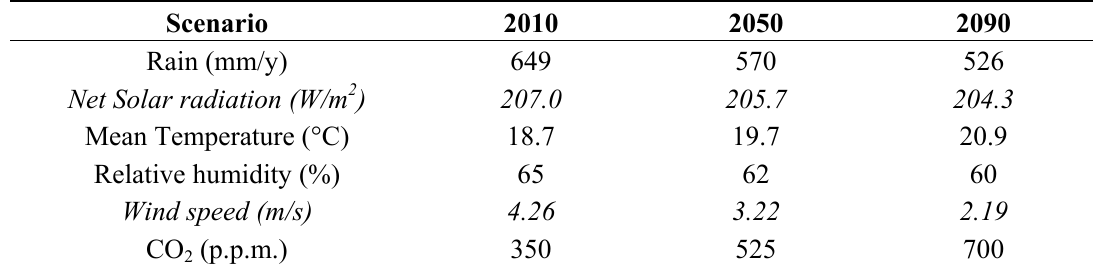
Table 1. Mean values for climatic scenarios generated by the Advanced Weather Generator (AWE-GEN) model or extrapolated by historical/literature data